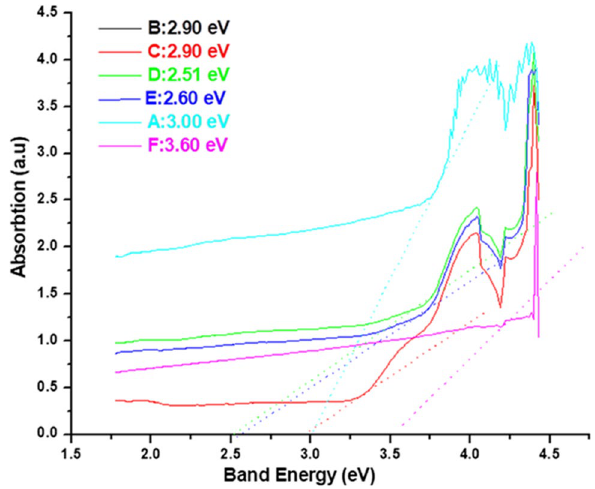
Fig. 2 Band gap energy of AC/CeO